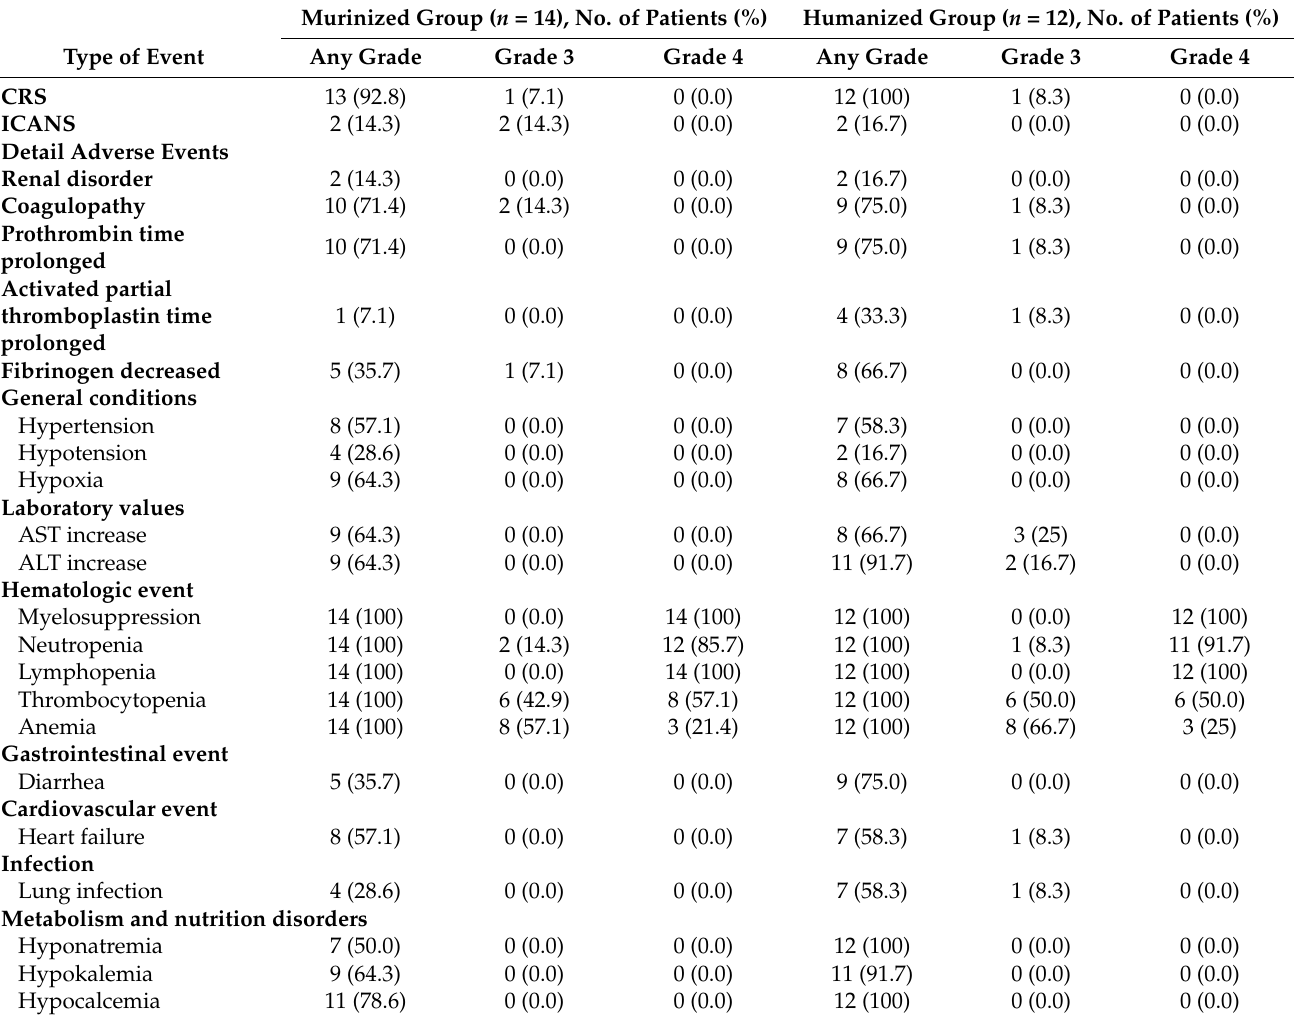
Table 2. CRS, ICANS, and adverse events post CAR-T cells infusion. Murinized Group ( n = 14), No. of Patients (%) Humanized Group ( n = 12), No. of Patients